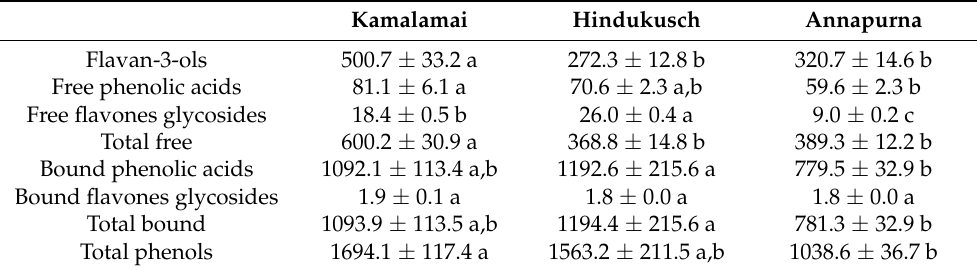
Table 3. Phenolic compounds contents ( µ g/g) in whole barley